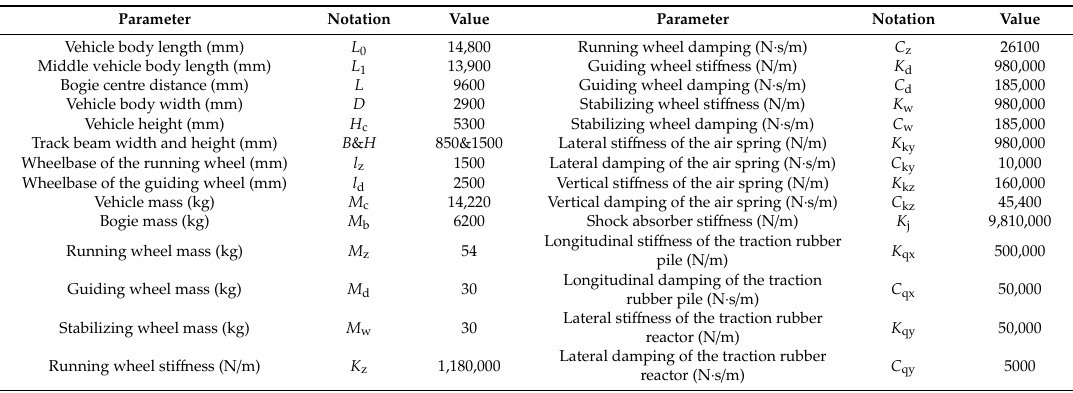
Figure 2. Topology graph of a straddle-type monorail. Table 2. Main parameters for the monorail vehicle.